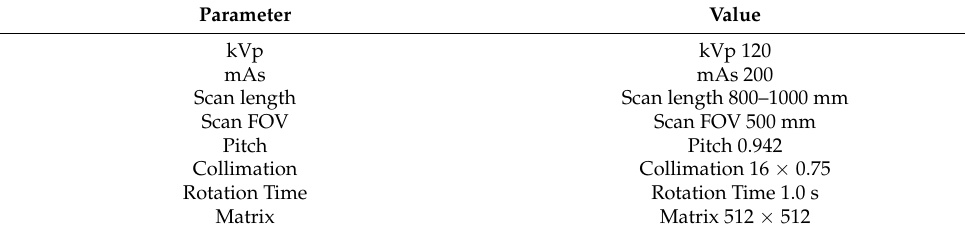
Table 2. Computed tomography